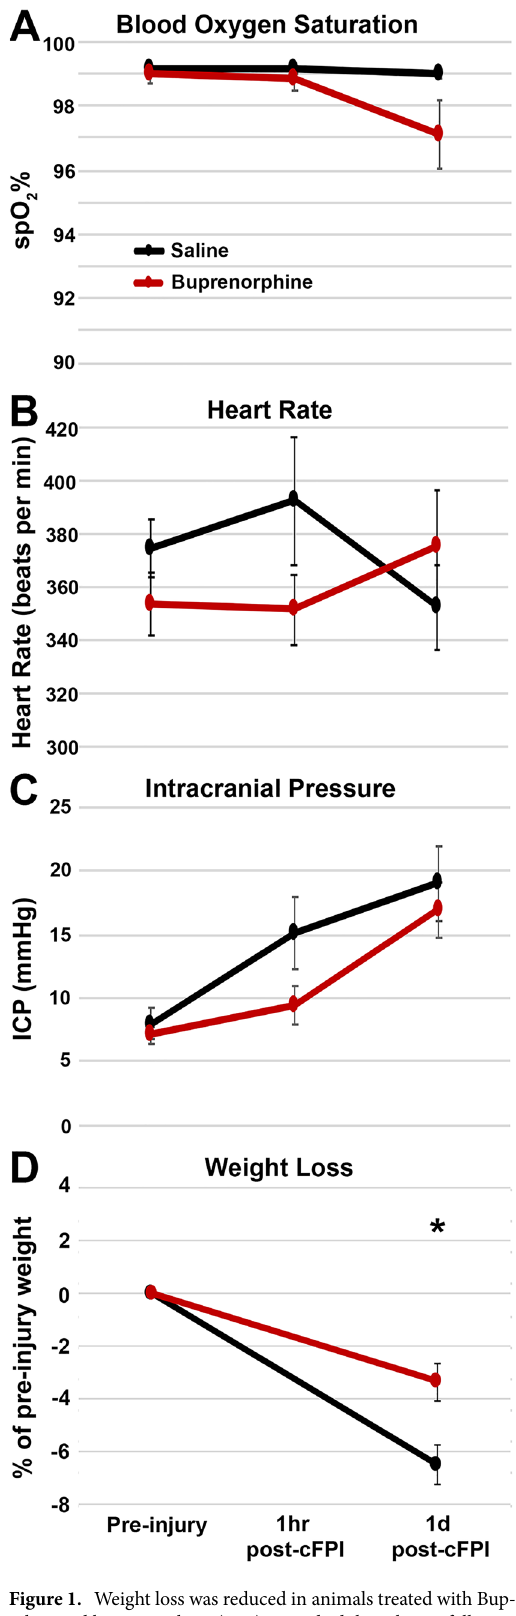
Figure 1. Weight loss was reduced in animals treated with Bup-SR-Lab at 1-day post-injury. Physiological readouts in saline and buprenorphine (Bup) treated adult male rats following central fluid percussion injury (cFPI). ( A ) Blood oxygen saturation, ( B ) heart rate, and ( C ) Intracranial pressure were unchanged with Bup. ( D ) Weight loss 1d following cFPI was less substantial in cFPI rats treated with Bup compared to saline. Figure was compiled using Adobe Photoshop CS., version 22.0 (2020), San Diego, CA. n = 6 rats/group. Mean ± SEM. * p < 0.05 compared to